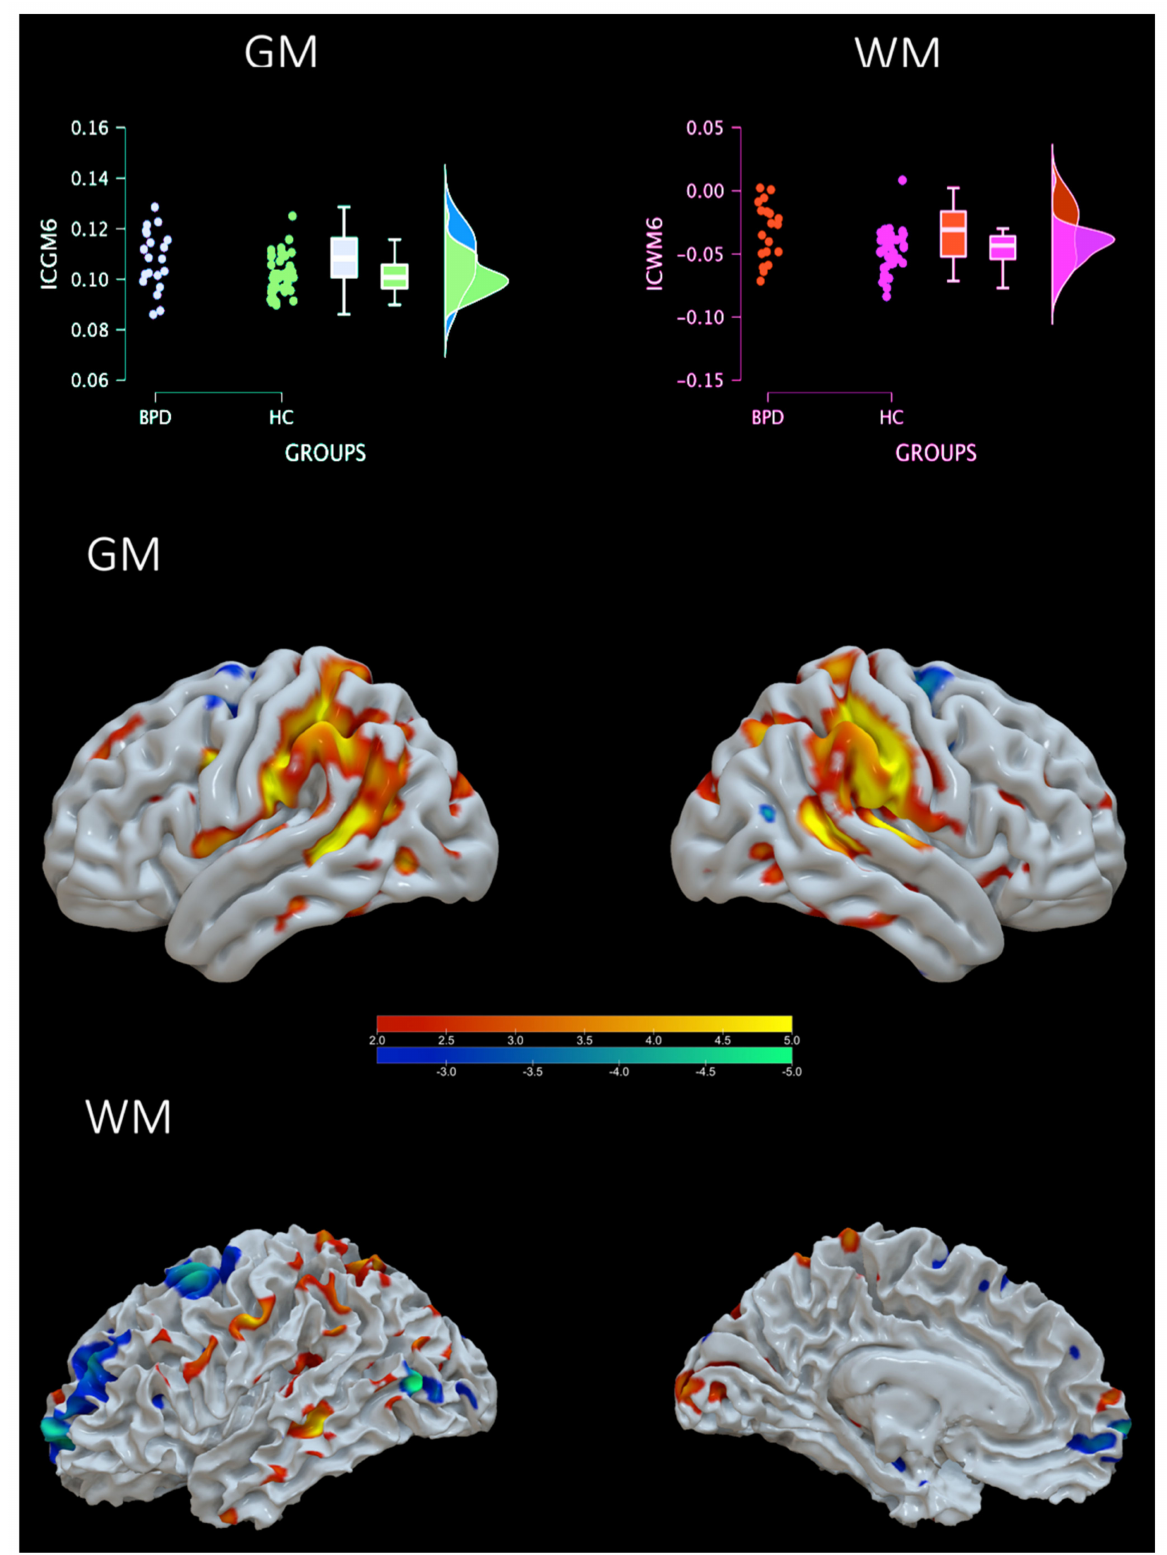
Figure 5. Brain plots from random forest analysis . Top: violin plots of the loading coefficients for GM and WM of the IC6. Bottom: brain plot of positive (increased GM - WM concentration) and negative (decreased GM-WM concentration) of